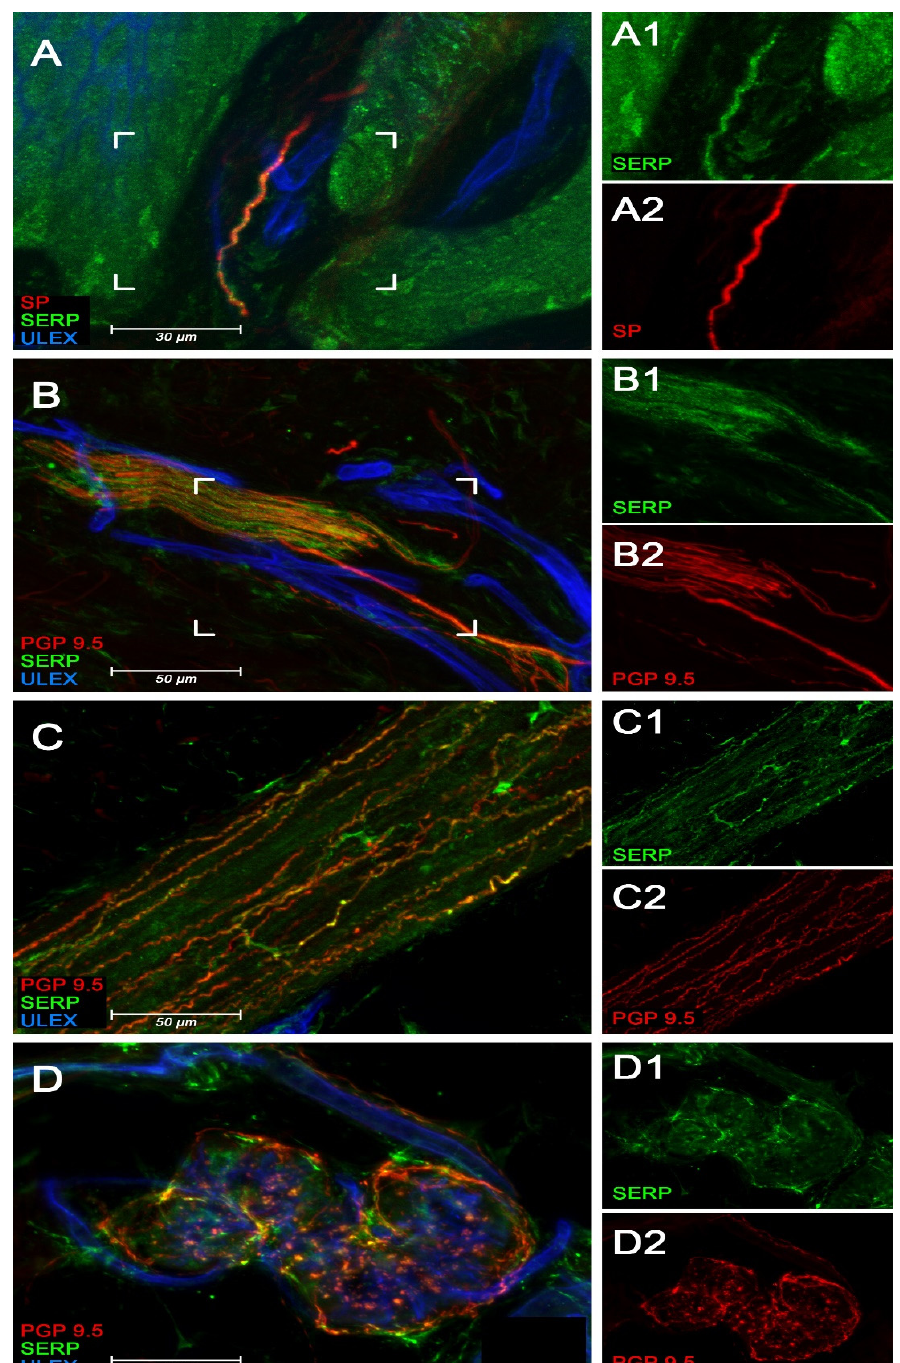
Figure 4. Confocal images demonstrating the presence of serpinin IR within nerve fibers in human skin from control subjects. On the left, the merged images ( A – D ) show colocalization of serpinin with neural markers. On the right, the unmerged images ( A1 , A2 , B1 , B2 , C1 , C2 , D1 , D2 ) allow to better appreciate the different stainings. ( A ): serpinin (green) colocalization with SP (red) in a sensory fiber within a dermal papilla. ( B ): serpinin (green) colocalization with the pan neuronal marker PGP 9.5 (red) in the fibers included in a nerve bundle in the reticular dermis. ( C ): serpinin (green) colocalization with PGP 9.5 (red) in pilomotor sympathetic nerves from an arrector pili muscle. ( D ): serpinin (green) colocalization with PGP 9.5 (red) in sudomotor sympathetic nerves around sweat tubules. Scale bar is 30 µm in ( A ) and 50 µm in ( B – D ). SP = substance P; PGP 9.5 = Pan neuronal marker protein gene product 9.5; ULEX = Ulex europaeus agglutinin 1.